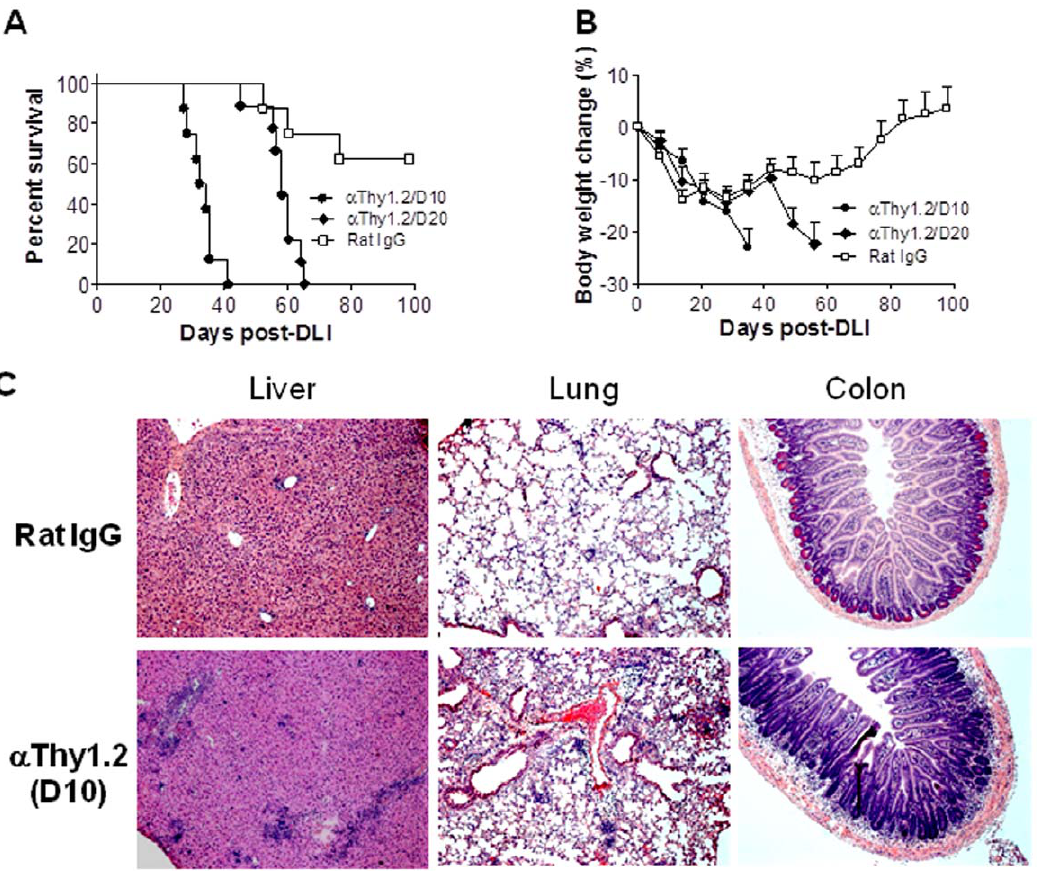
Figure 4. Post-DLI depletion of donor BM-derived T cells exacerbates GVHD in mixed chimeras. Lethally (8 Gy) irradiated BALB/c mice were reconstituted with a mixture of TCD BALB/c plus WT B6 (Thy1.2 + ) BMCs 8 weeks before DLI (i.e., injection of 1.5 6 10 7 splenocytes) from B6.PL- Thy1a (Thy1.1 + ) donors. Donor BM-derived T cell depletion in these MCs was performed by injection (i.p.) of anti-Thy1.2 antibodies starting at day 10 (n=8) or day 20 (n=9) after DLI as described in Materials and Methods. Control MCs (n=8) were treated with Rat IgG. Shown are survival (A), body weight changes (B) and histological analysis (H&E; 6 100) of liver, lung and colon from representative MCs at day 20-post antibody treatment (i.e., 30 days post-DLI)